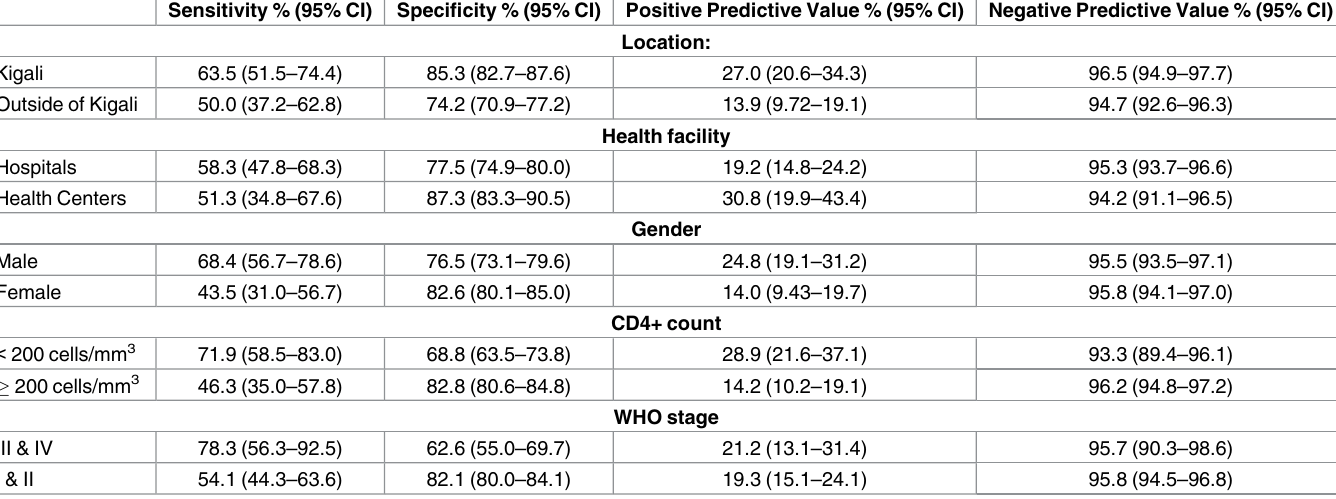
Table 4. Operating Characteristics of the National TB Screening Tool Stratified by Participant and Facility Characteristics for Confirmed and Probable TB Cases